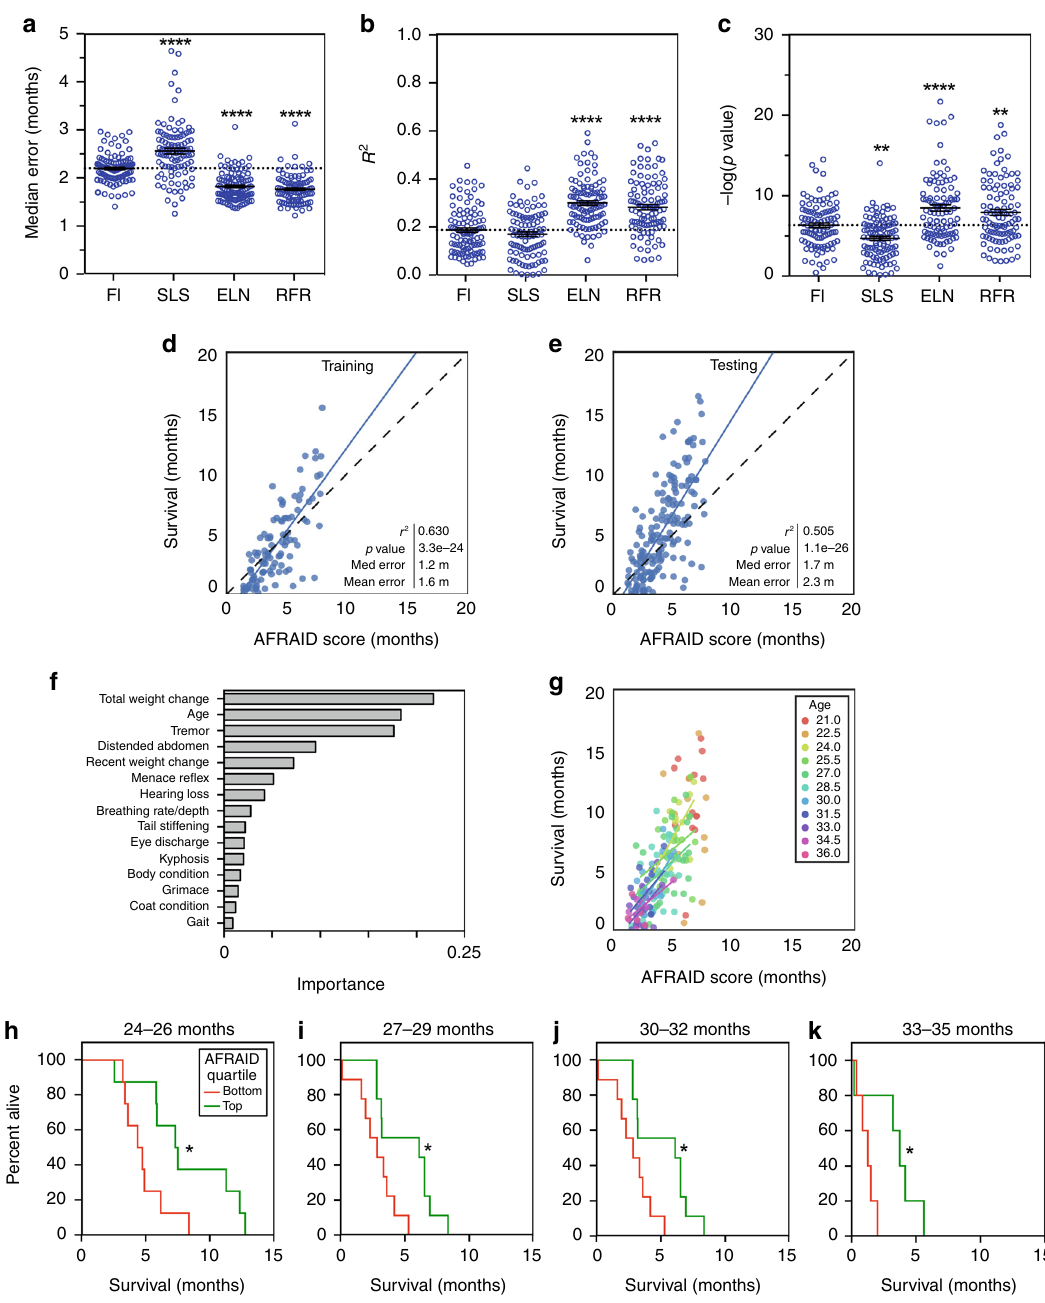
Fig. 4 Multivariate regressions of FI items to predict life expectancy (AFRAID clock). a – c Median error, r 2 values, and p values for univariate regression of Frailty Index (FI) score, and multivariate regressions of the individual FI items using either simple least squares (SLS), elastic net (ELN), or random forest regression (RFR) for life expectancy in the mouse training set. All models were tested with bootstrapping with replacement repeated 100 times, and each bootstrapping incidence is plotted as a separate point. **** p < 0.0001 and *** p < 0.001 compared to FI model with one-way ANOVA. Error bars represent standard error of the mean. d , e Random forest regression of the individual FI items for life expectancy on training and testing datasets (data was randomly divided 50:50, separated by mouse rather than by assessment, n = 106 datapoints for training and n = 165 for testing), plotted against actual survival. This model is termed the AFRAID ( A nalysis of Frai lty and D eath) clock. Correlation determined by Pearson correlation coef fi cients. f Importances of top 15 items included in the AFRAID clock. g AFRAID clock scores plotted against actual survival for individual mouse age groups (as demonstrated by different colors) in the testing dataset. Regression lines are only graphed for ages where there is an r 2 value >0.1. h – k Kaplan – Meier curves of the bottom (red lines) and top (green lines) quartiles of AFRAID clock scores for mice over 1 – 2 assessments at 24 – 26, 27 – 29, 30 – 32, and 33 – 35 months of age. * p < 0.05 compared with two-sided log-rank test. Exact p values, respectively: 0.032, 0.015, 0.026, and 0.034. Source data are provided as a Source Data fi